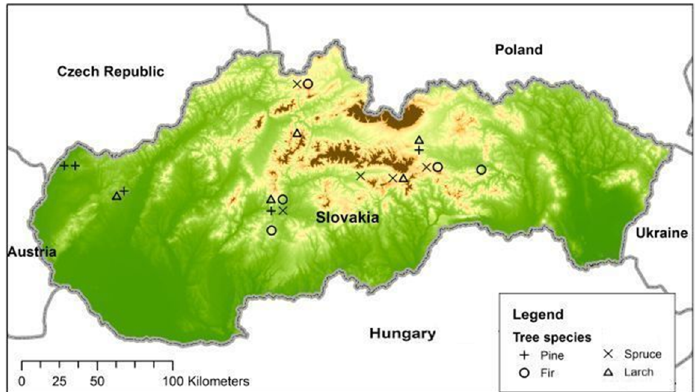
Figure 1. Location of examined coniferous stands [24].